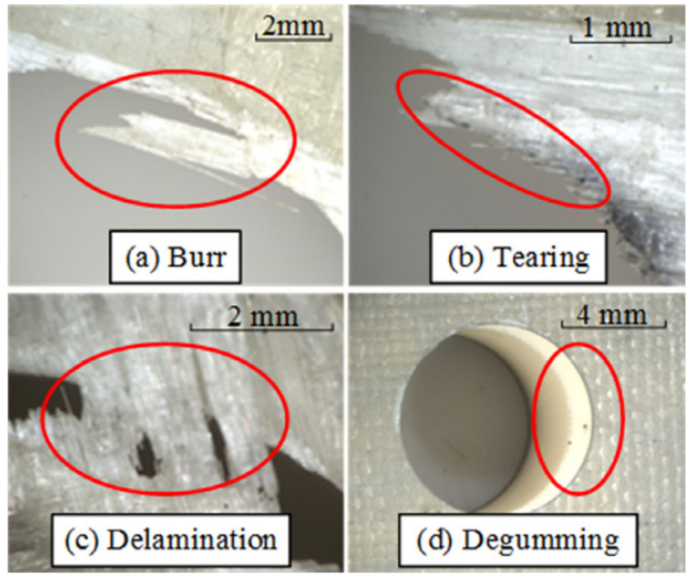
Figure 15. Exit defects of Al 2 O 3 /GFRP composite plate processed using low-frequency axial vibration drilling (Repronted with permission from Ref. [147], 2020 copyright Elsevier Ltd.).